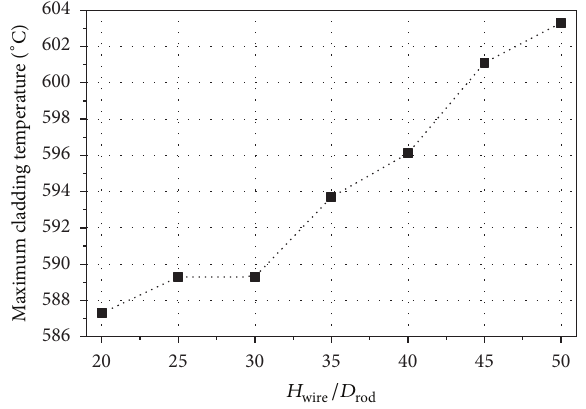
Figure 8: Pressure drop of two kinds of assembly.